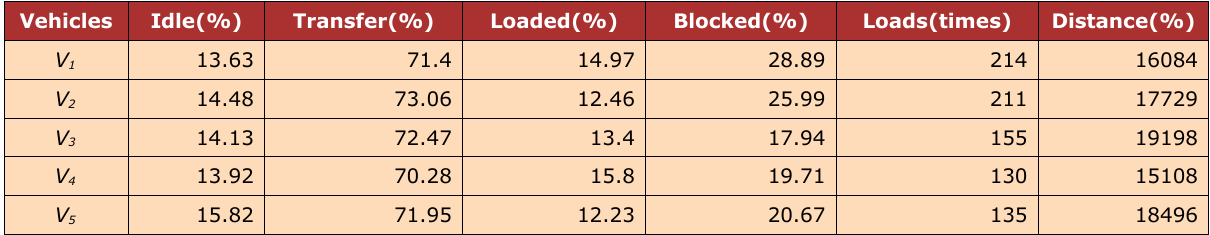
Table 5. The simulation results after increasing vehicles